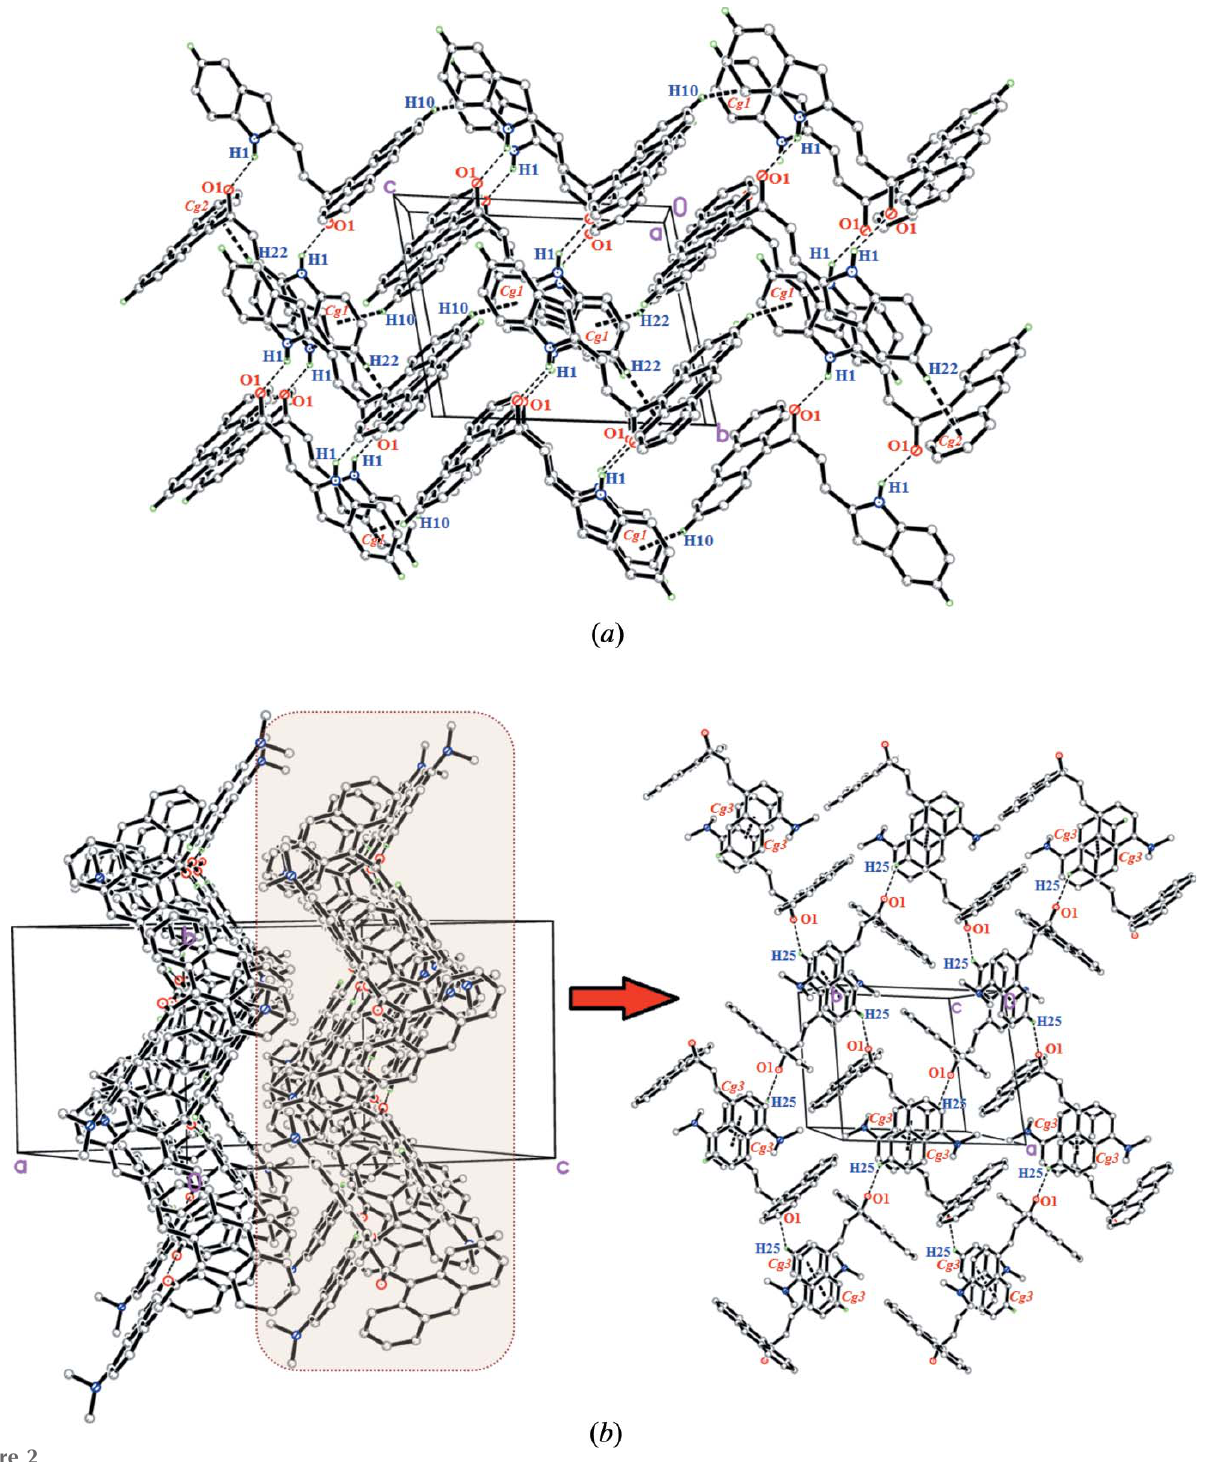
Figure 2 Packing diagram showing ( a ) weak N—H (cid:3)(cid:3)(cid:3) O and C—H (cid:3)(cid:3)(cid:3) (cid:2) interactions in (I) and ( b ) weak C—H (cid:3)(cid:3)(cid:3) O and (cid:2) – (cid:2) interactions in